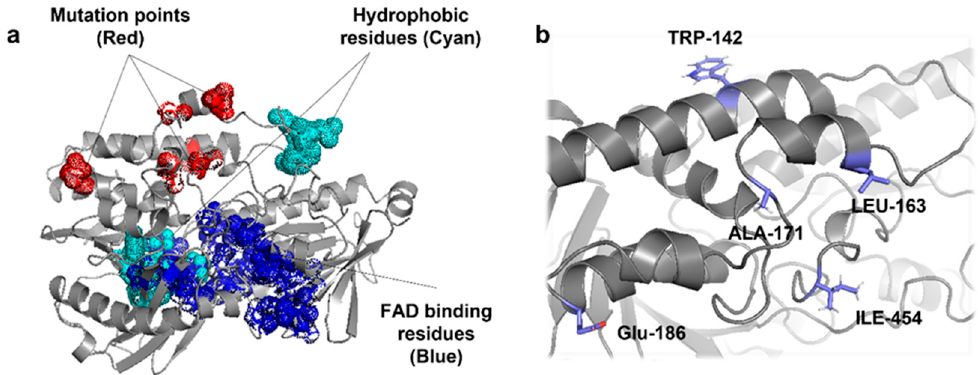
Figure 5. The in-silico-predicted structure of FAD binding residues and hydrophobic residues in CrtI RS ( a ) and five amino acid mutation sites of CrtI RS ( b ).